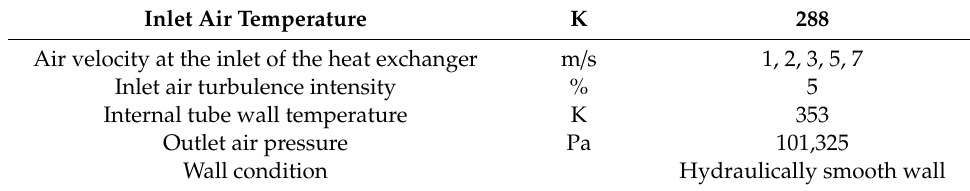
Table 3. Boundary conditions for Computational fluid dynamics simulations.